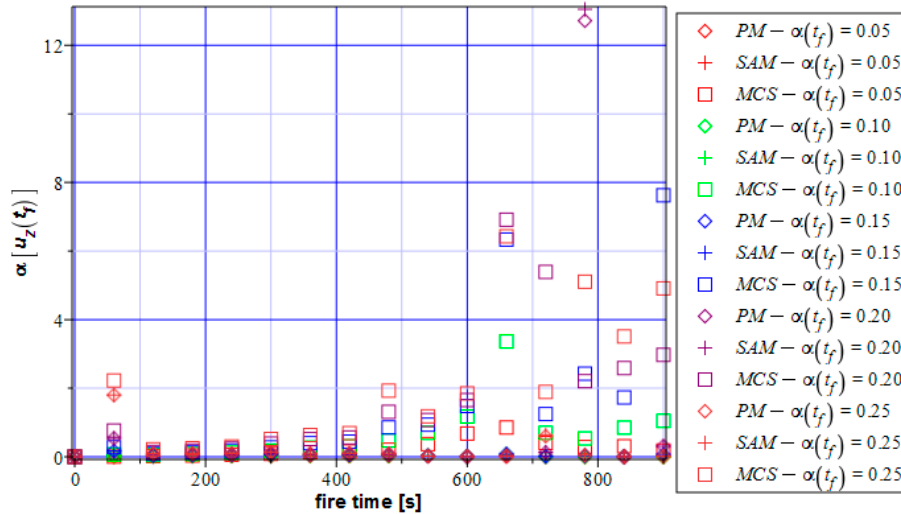
Figure 12. Coefficient of the variation of the vertical deflections.